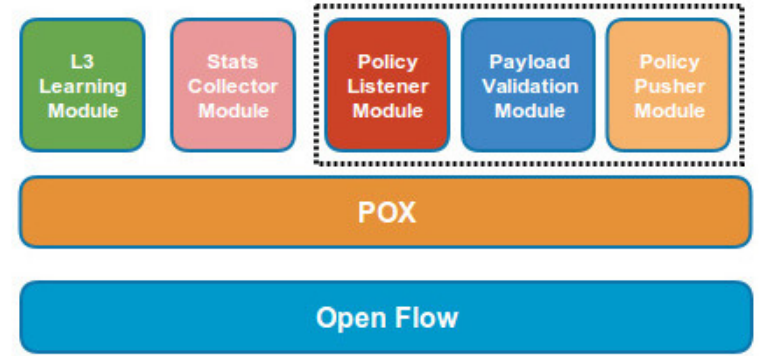
Figure 4. Component Architecture of